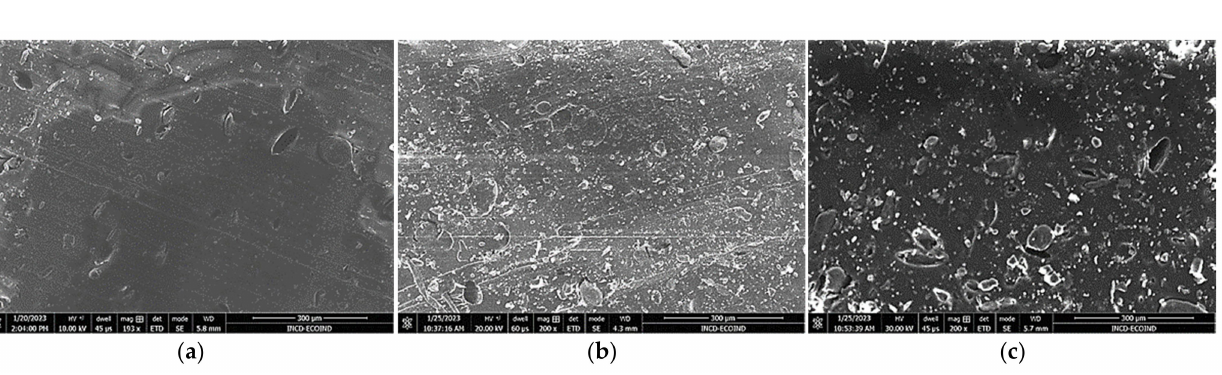
Figure 4. SEM images of polymer MSBS composites with 5% ( a ), 10% ( b ), and 20% ( c ) Chlorella vulgaris